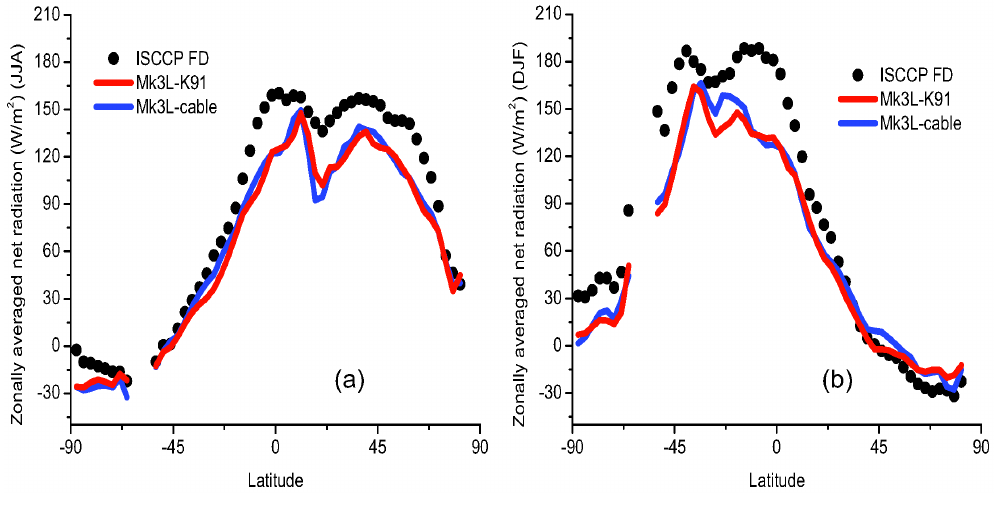
Fig. 5. Zonal net surface radiation (Wm − 2 ) for JJA (left) and DJF (right) for the two Mk3L simulations (observations are ISCCP FD, Zhang et al.,